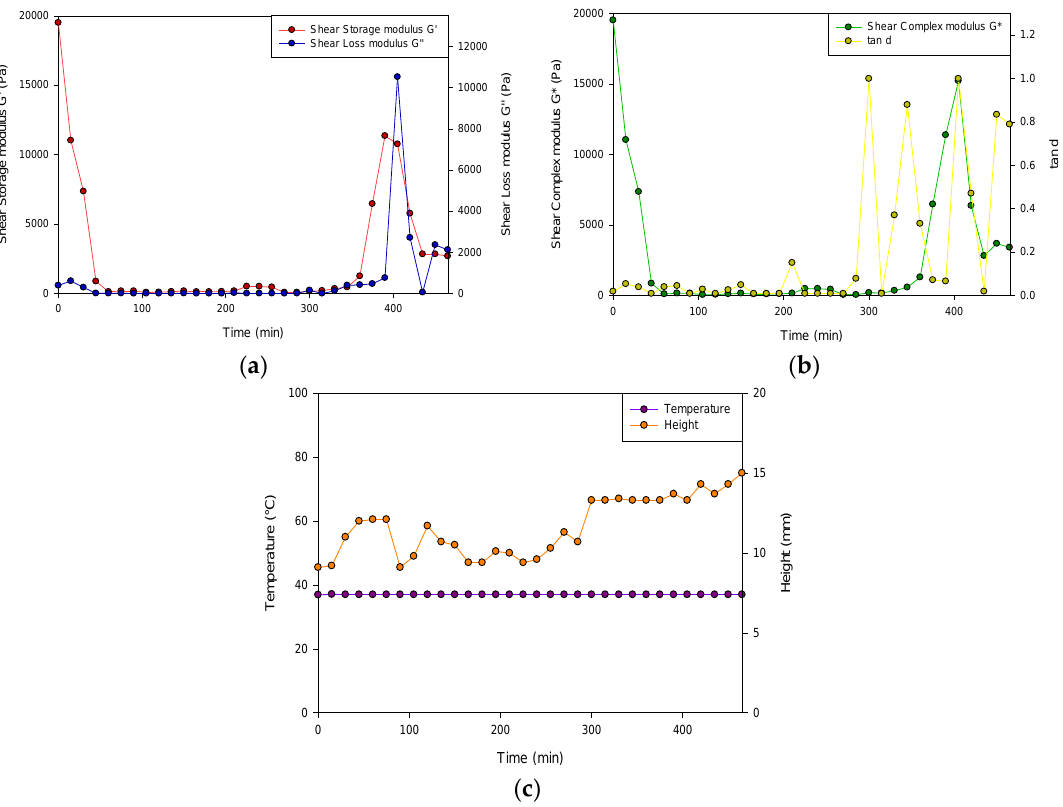
Figure 6. Viscoelastic profiles of the PVA–PAA hydrogel where ( a ) represents the shear storage modulus ( G′; SD ≤ 352 Pa in all cases) and shear loss modulus ( G″; SD ≤ 520 Pa in all cases), ( b ) represents the shear complex modulus (G* ; SD ≤ 265 Pa in all cases) and tan δ of the hydrogel (SD ≤ 0.088 in all cases) and ( c ) depicts the height of the hydrogel (SD ≤ 1.2 mm in all cases) and temperature of the test over the 8-h test period (SD ≤ 0.0 ·°C in all cases).